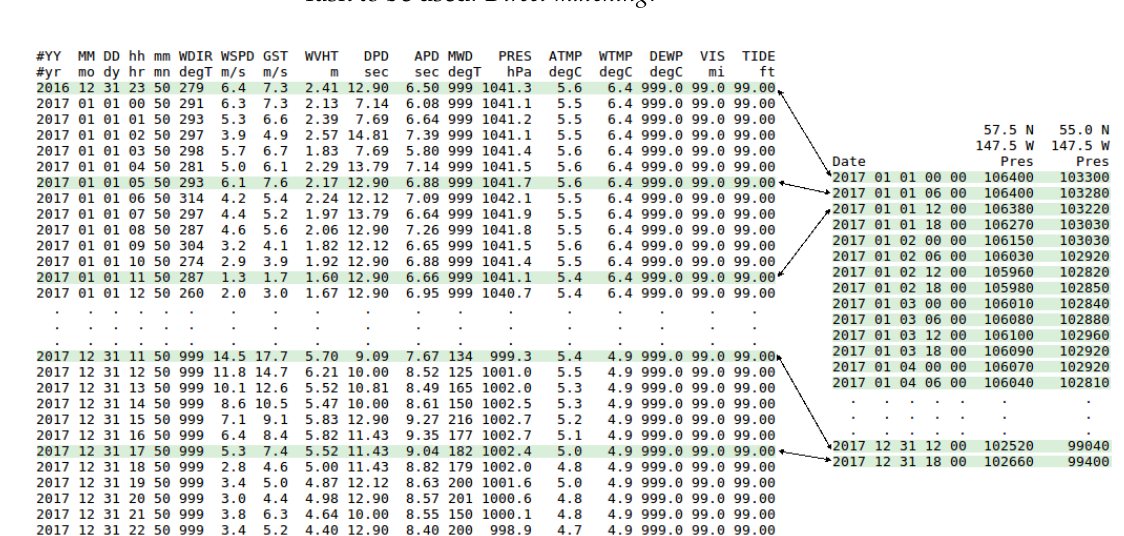
Figure 7. An example of matching the data from NDBC ( left ) and NNRP ( right ).